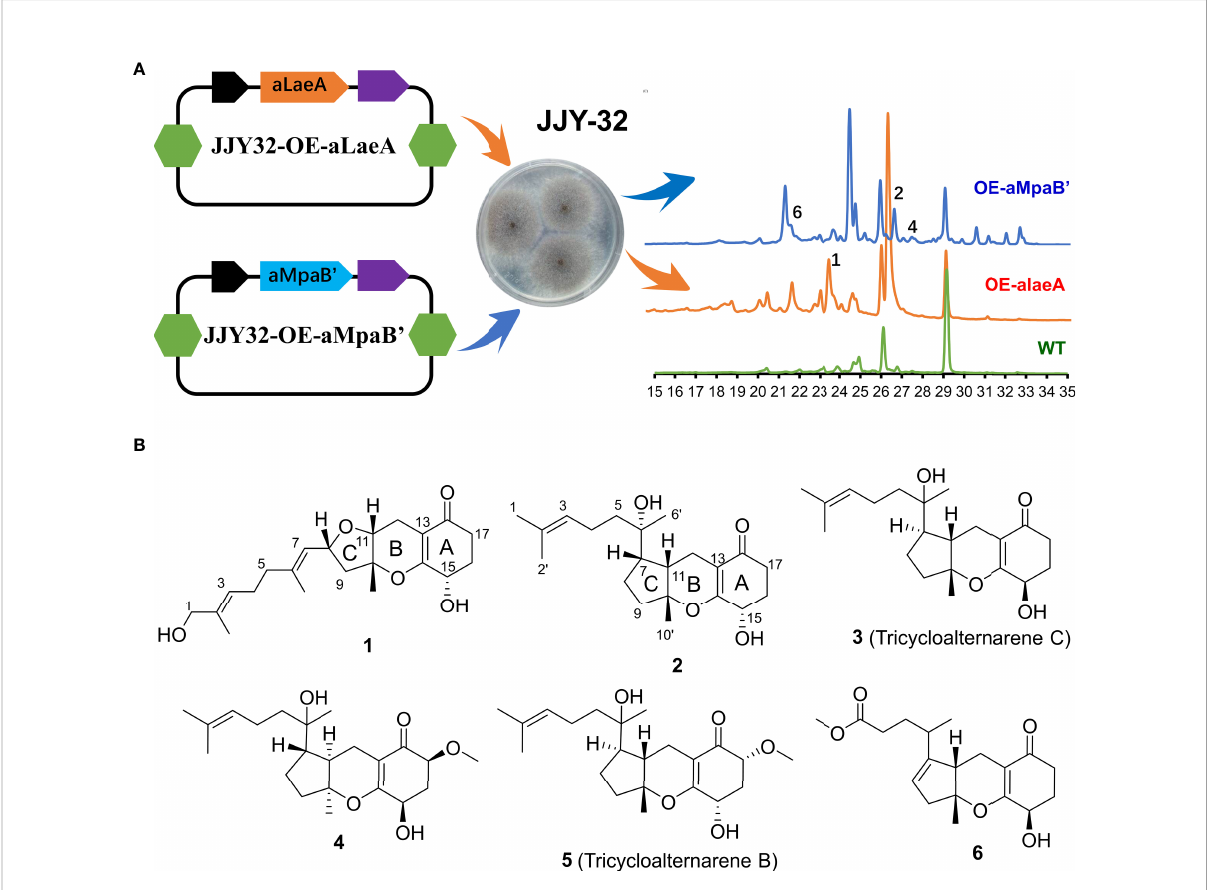
FIGURE 1 The overexpression of aLaeA and aMpaB in A alternata JJY-32. (A) Heterologous expression of aLaeA and aMpaB altered the metabolic pro fi le of JJY-32 and led to the production of compounds 1-2 , 4, and 6 by HPLC (mobile phase: 5% methanol, 5 min; 100% methanol, 35 min); (B) Structure of compounds obtained from cultures of JJY32-OE-alaeA and JJY32-